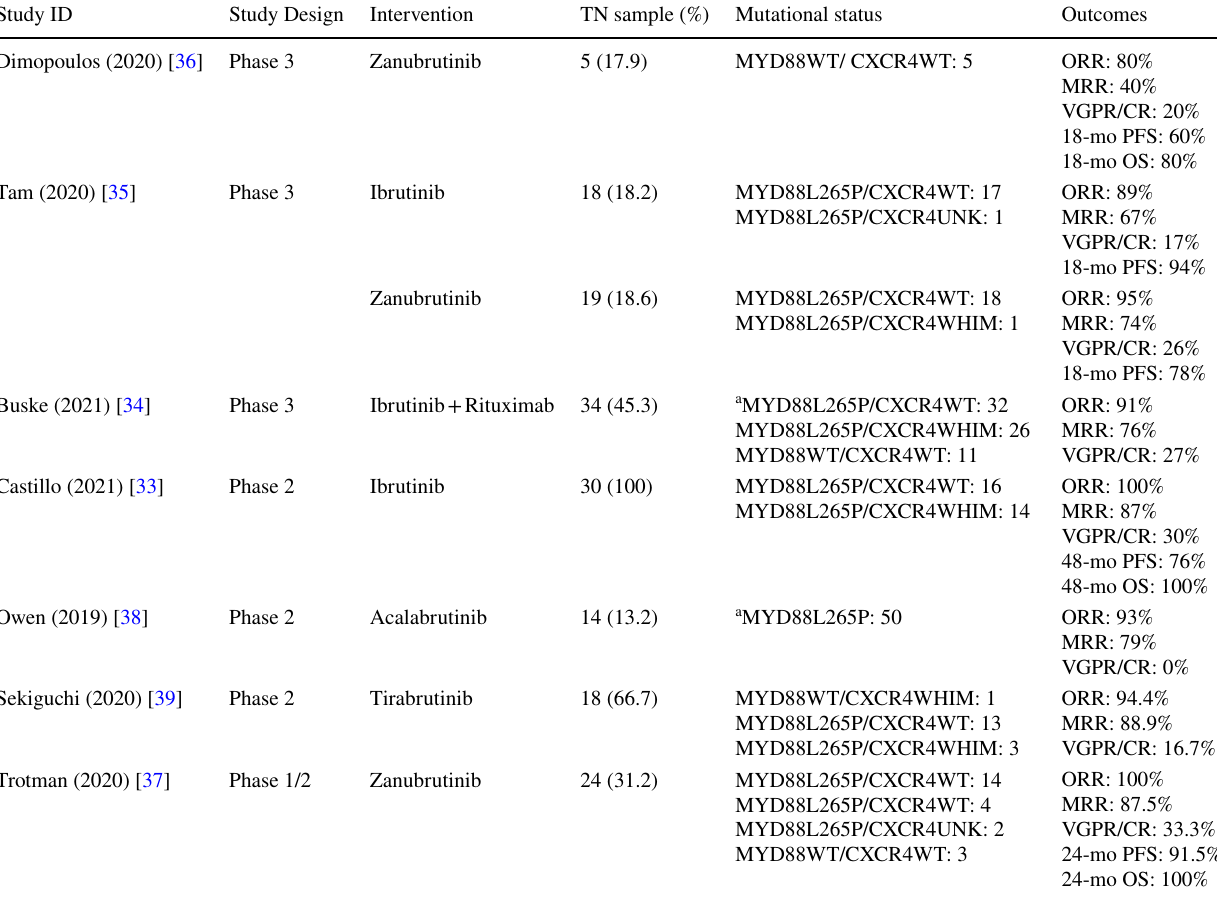
Table 1 Characteristics and outcomes of clinical trials using BTKi in front line settings in WM